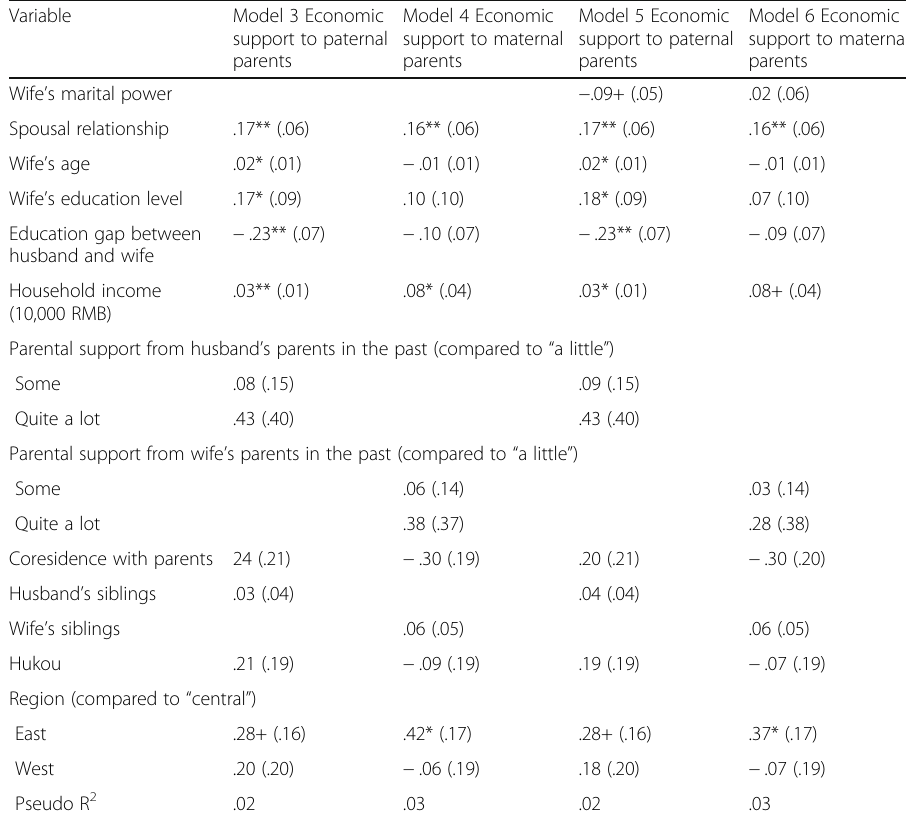
Table 3 The influence of spousal relationship on intergenerational resource allocation in the